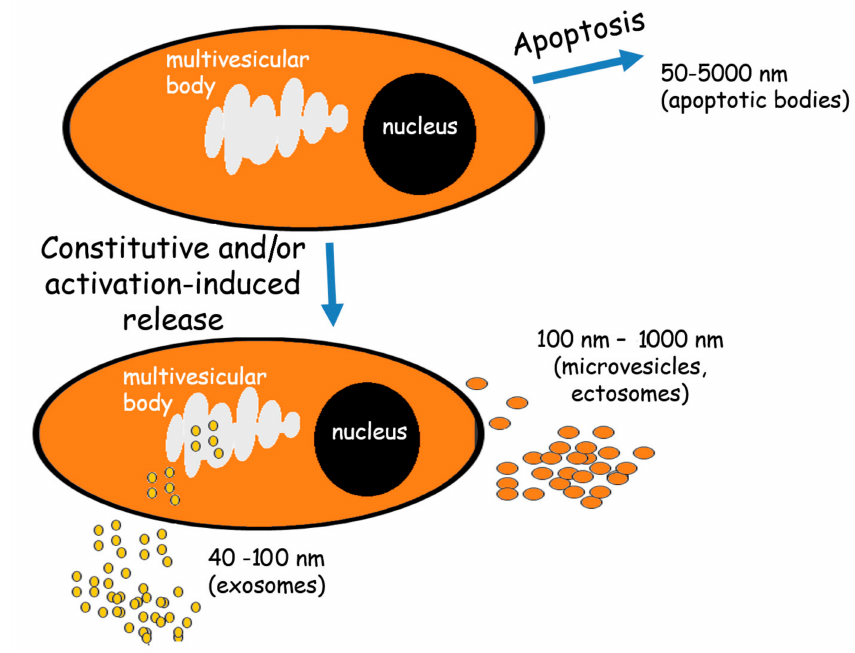
Figure 1. The extracellular vesicles (EVs) release. Alive cells release both exosomes and microvesicles either constitutively and/or under activation. Exosomes are formed from multivesicular bodies while microvesicles arise through direct budding from the plasma membrane. The cells undergoing apoptosis release apoptotic bodies formed by random